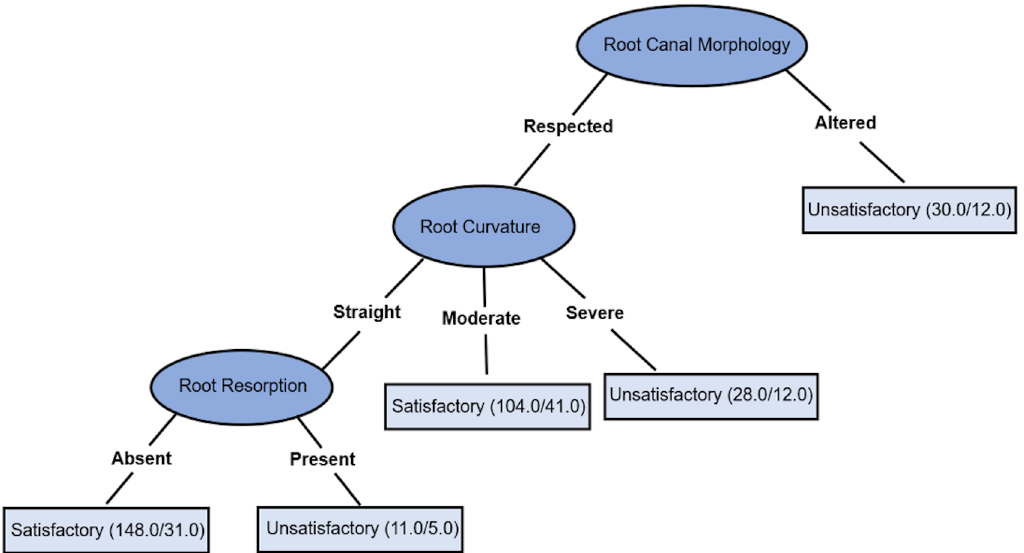
Figure 3- Decision tree B: Prediction of technical quality of non-surgical root canal retreatment, including variables related to demographic data, medical history, and diagnosis - (1) For altered RCM, the technical quality was unsatisfactory; (2) For respected RCM and severe RC, the technical quality was unsatisfactory, whereas, for moderate RC, it was satisfactory; (3) For respected RCM, straight RC, and presence of root resorption, the technical quality was unsatisfactory. When root resorption was absent, the technical quality was satisfactory. The values in parentheses point out the total number of correctly/incorrectly classified instances in each leaf per node (Accuracy of